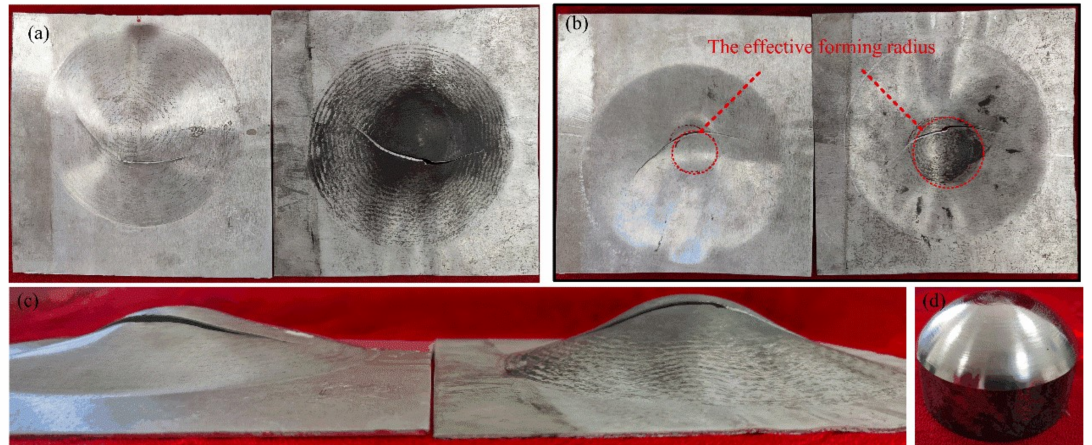
Figure 13. Photographs of cracked AZ31 magnesium alloy in CBS forming process (left: Step1; Right: Scheme 2. ( a ) Overhead view of deformed sheet; ( b ) Bottom view of deformed sheet; ( c ) Side view of deformed sheet; ( d ) The bottom